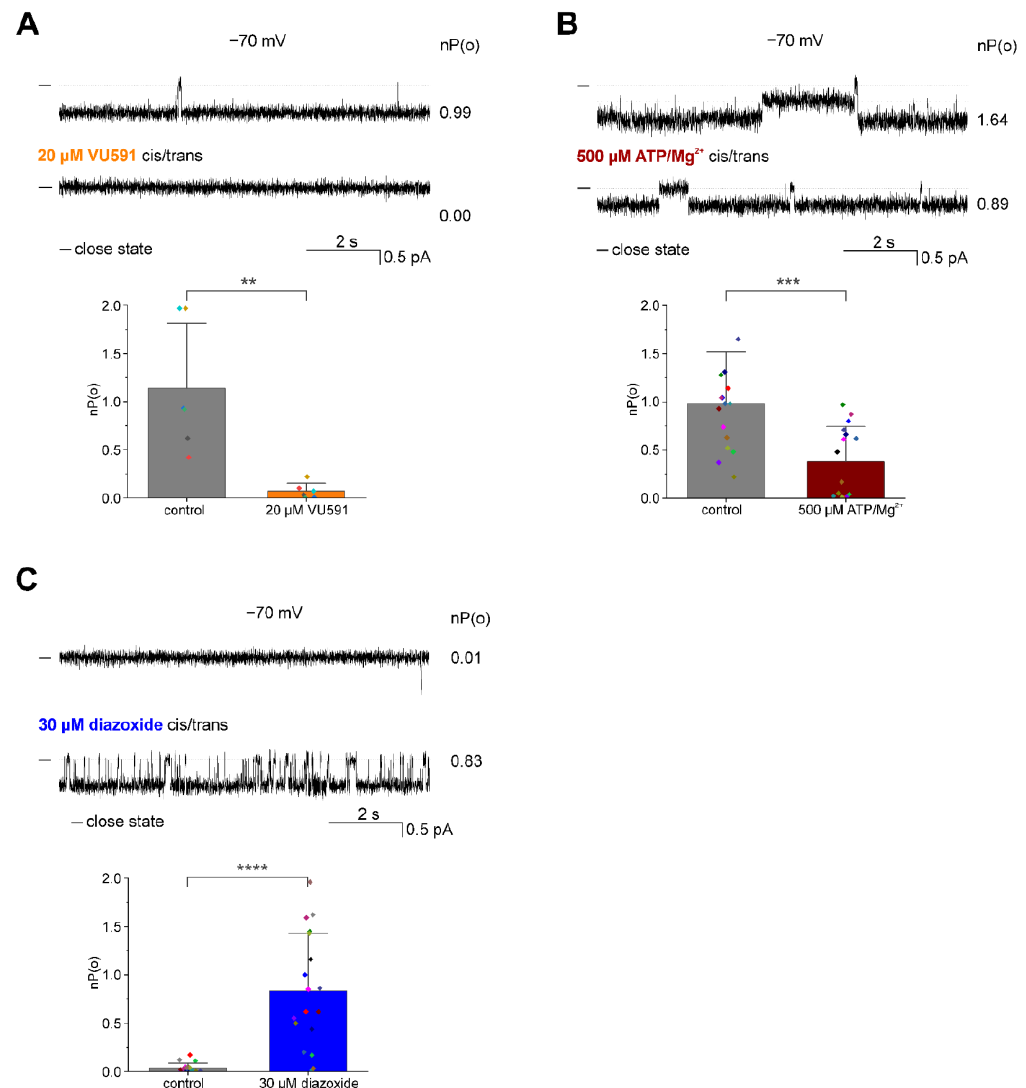
Figure 3. Pharmacological characterization of the activity of ROMK2 channel protein reconstituted in planar lipid bilayers. ( A ) VU591, a known inhibitor of the ROMK channel, inhibits recorded channel activities. Top panel: representative single-channel recordings at − 70 mV under control conditions and in the presence of 20 µM VU591. Lower panel: channel open probability, nP(o), under control conditions and in the presence of 20 μM VU591 ( n = 6). ( B ) ATP/Mg 2+ , a known mitoK ATP and ROMK channel inhibitor, blocks recorded channel activities. Top panel: Representative single-channel recordings at − 70 mV under the control conditions and in the presence of 500 μM ATP/Mg 2+ . Lower panel: channel open probability, nP(o), under the control conditions and in the presence of 500 μΜ ATP/Mg 2+ ( n = 16). ( C ) Diazoxide, a known mitoK ATP channel opener, increases observed channel activity. Top panel: Representative single-channel recordings of ROMK2 at − 70 mV under the control conditions and after the addition of 30 µM diazoxide. Lower panel: channel open probability, nP(o) , under the control conditions and in the presence of 30 μM diazoxide ( n = 18). “ - ” indicates the closed state of the channel. The results related to channel open probability are presented as means ± SD. ** p < 0.01, *** p < 0.001, **** p < 0.0001.